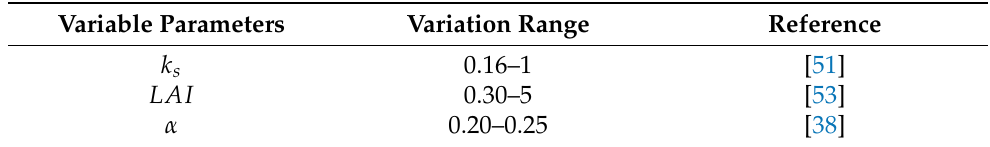
Table 2. Variation range for the variable parameters that influence solar absorptance coefficient and related